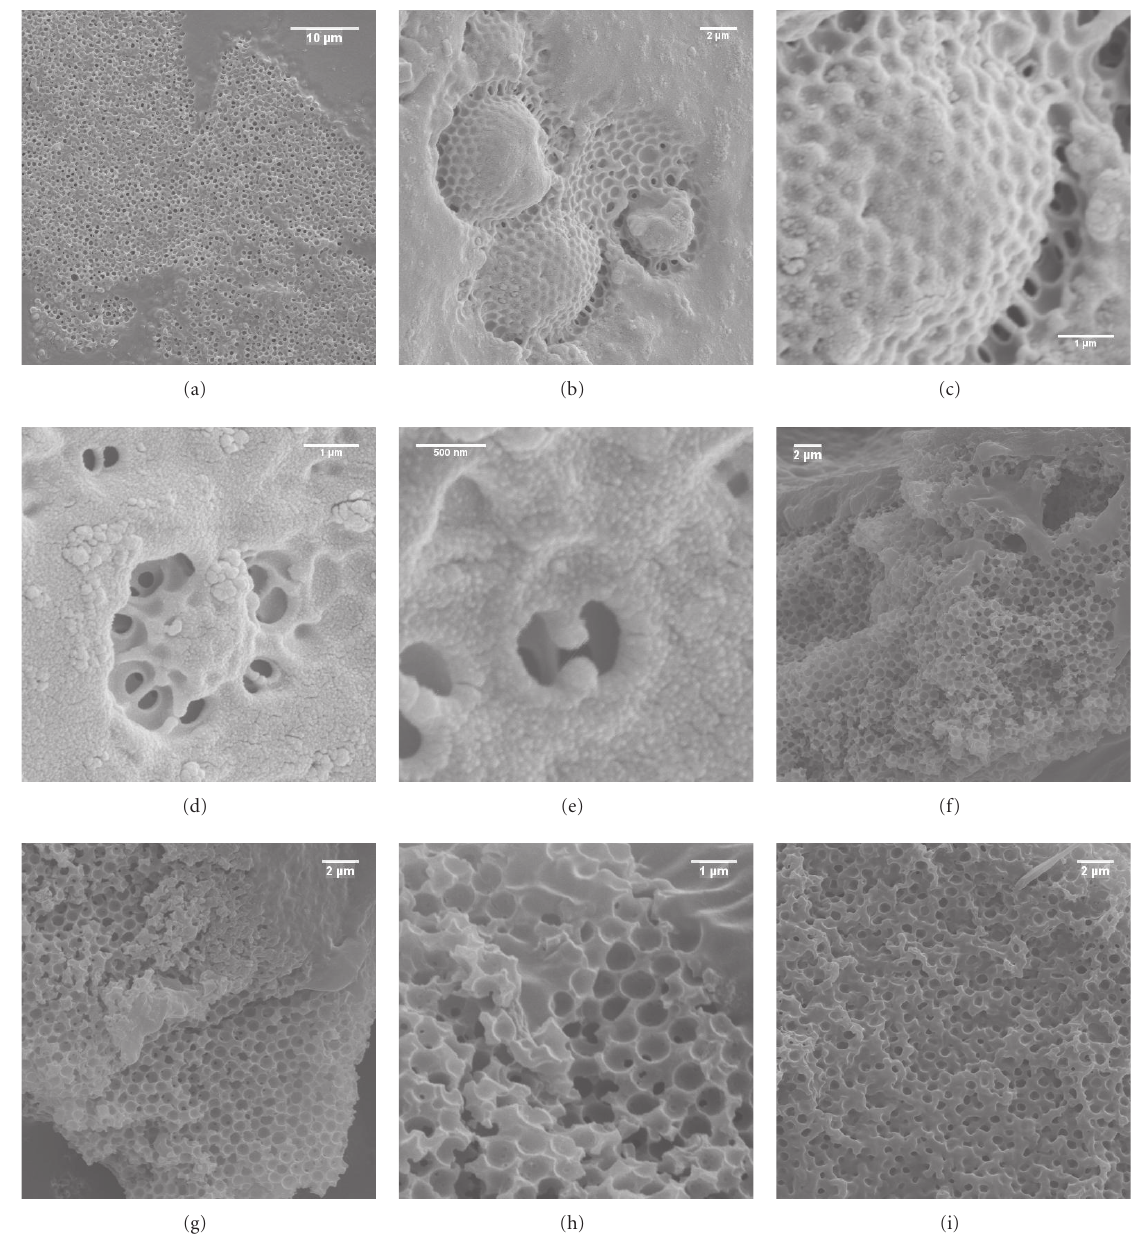
Figure 3: SEM images of the templated PEGDA polymer showing an interconnected pore network (a–e) on the outer surface that extends to the (f–i) inside the material. The scale bar lengths are given in